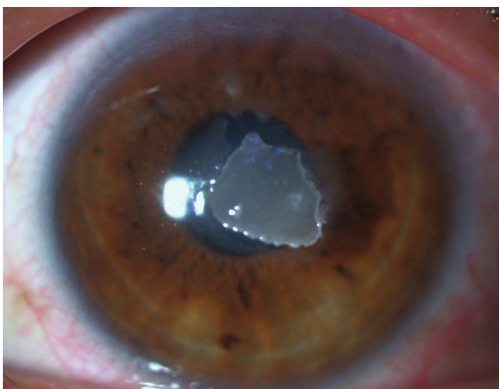
Figure 3: Corneal image at the final visit at 5 months after surgery. Little opacity was found in the